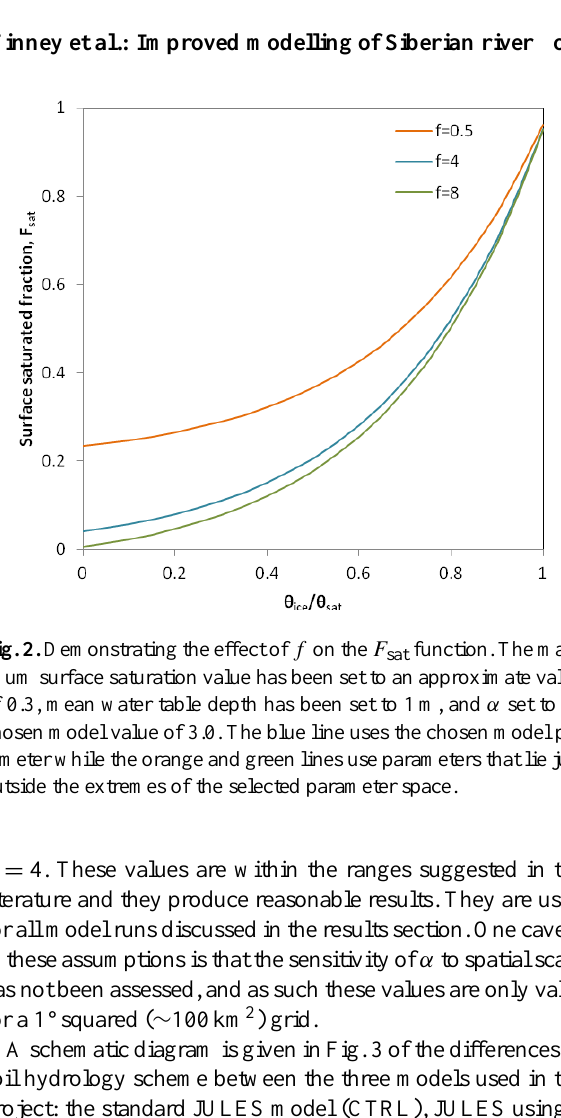
F function. The maximum surface 3 sat